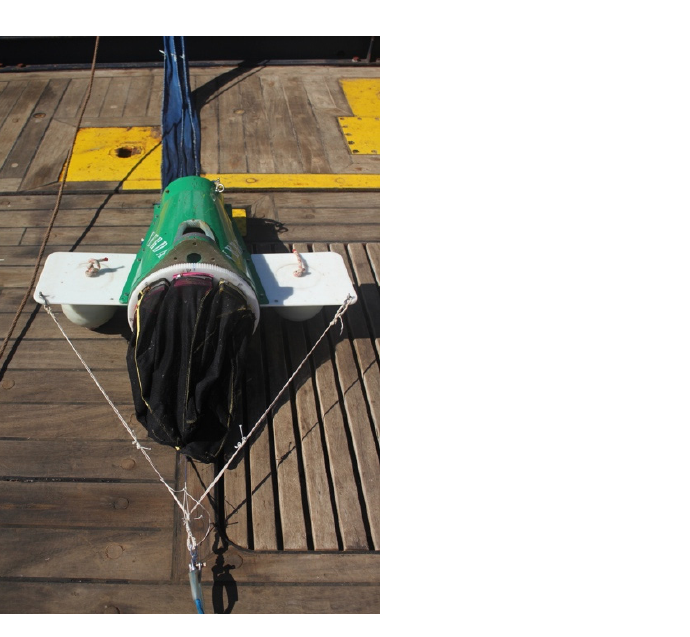
Figure 2. View, in inverted position, of vehicle without the casing. Observe the way collector bags are attached to sea anchor